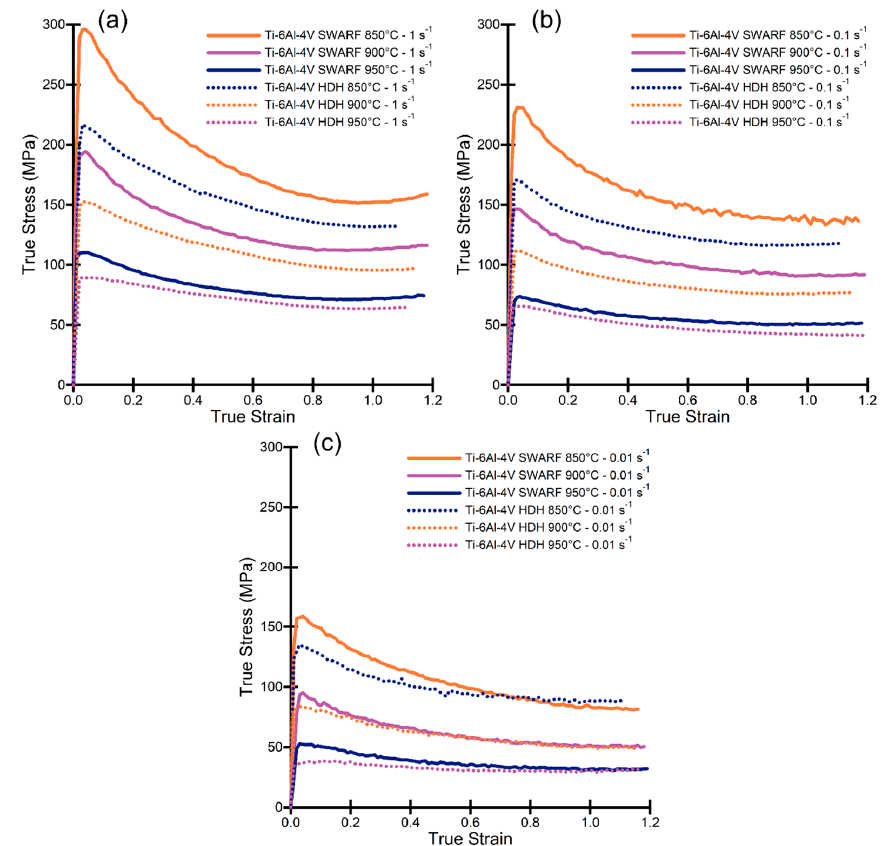
Figure 10. Flow curves showing true stress vs. true strain behaviour for Ti-6Al-4V swarf consolidated via FAST under axisymmetric compression at 850, 900, and 950 °C: ( a ) deformed with a strain rate of 1 s − 1 ; ( b ) deformed with a strain rate of 0.1 s − 1 ; ( c ) deformed with a strain rate of 0.01 s − 1 . Flow curves for Ti-6Al-4V HDH powder consolidated via FAST are also shown for comparison.